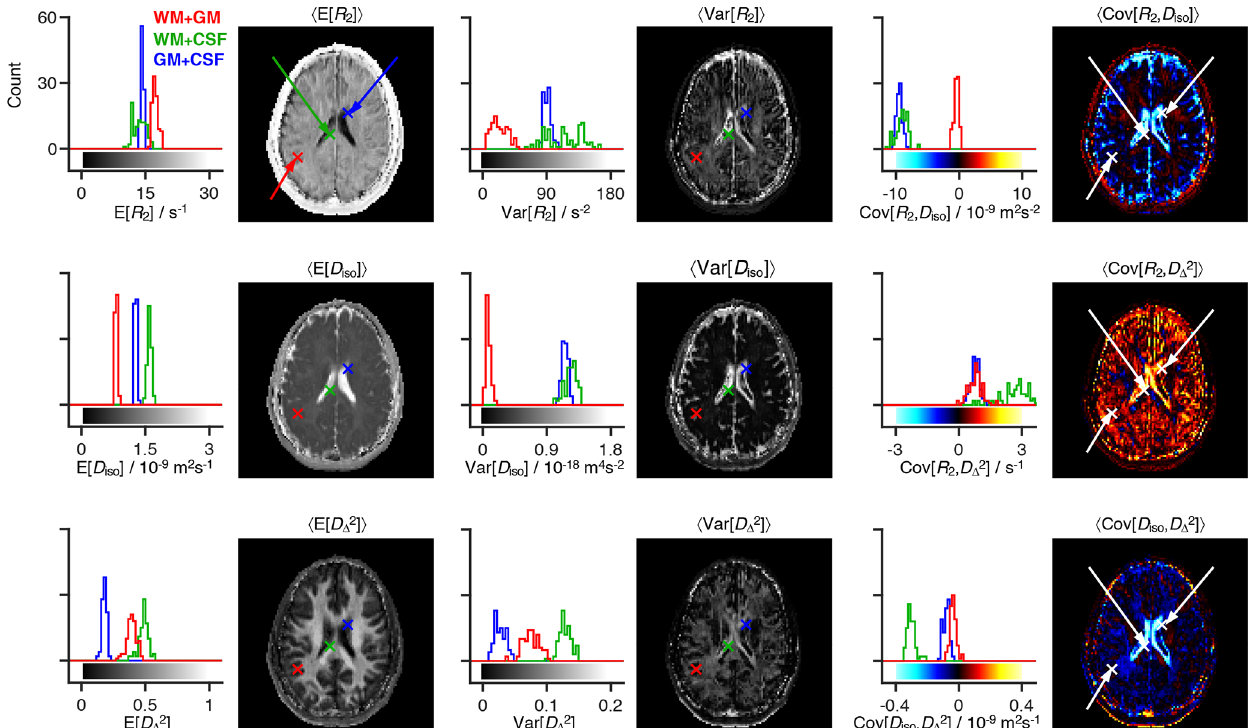
Figure 3. Statistical measures derived from the relaxation–diffusion distributions. The ensemble of 96 distinct P ( R 2 , D ) solutions was used to calculate means E[ x ], variances Var[ x ], and covariances Cov[ x , y ] of all combinations of transverse relaxation rate R 2 , isotropic diffusivity D iso , and squared anisotropy D (cid:49) 2 . The statistical measures were all derived from the entire R 2 - D distribution space on a voxel-by-voxel basis. Histograms are used to represent the parameter sets calculated for three voxels containing binary mixtures of white matter (WM), gray matter (GM), and cerebrospinal fluid (CSF). Each histogram comprises 96 estimates of a single statistical measure. The averages of statistical measures, (cid:104) E [ x ](cid:105) , (cid:104) Var [ x ](cid:105) and (cid:104) Cov [ x,y ](cid:105) , are displayed as parameter maps whose color scales are given by the bars along the abscissas of the histograms. The crosses and arrows identify the heterogeneous voxels analyzed in the histograms; notice that the signaled points correspond to the average (as measured by the median) of the ensembles of plausible solutions shown in the